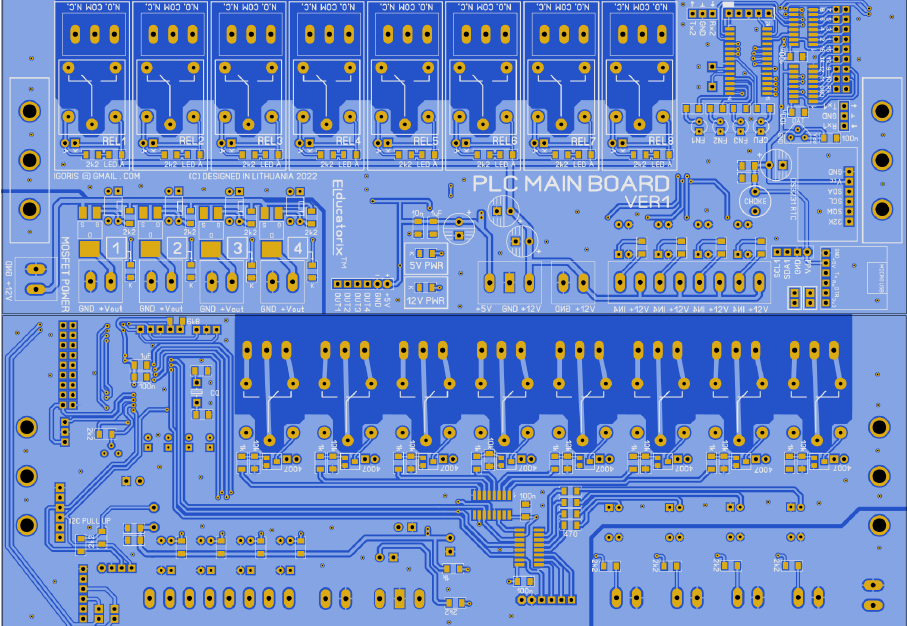
Figure 10. PCB view of the main electronic circuit of the controller.